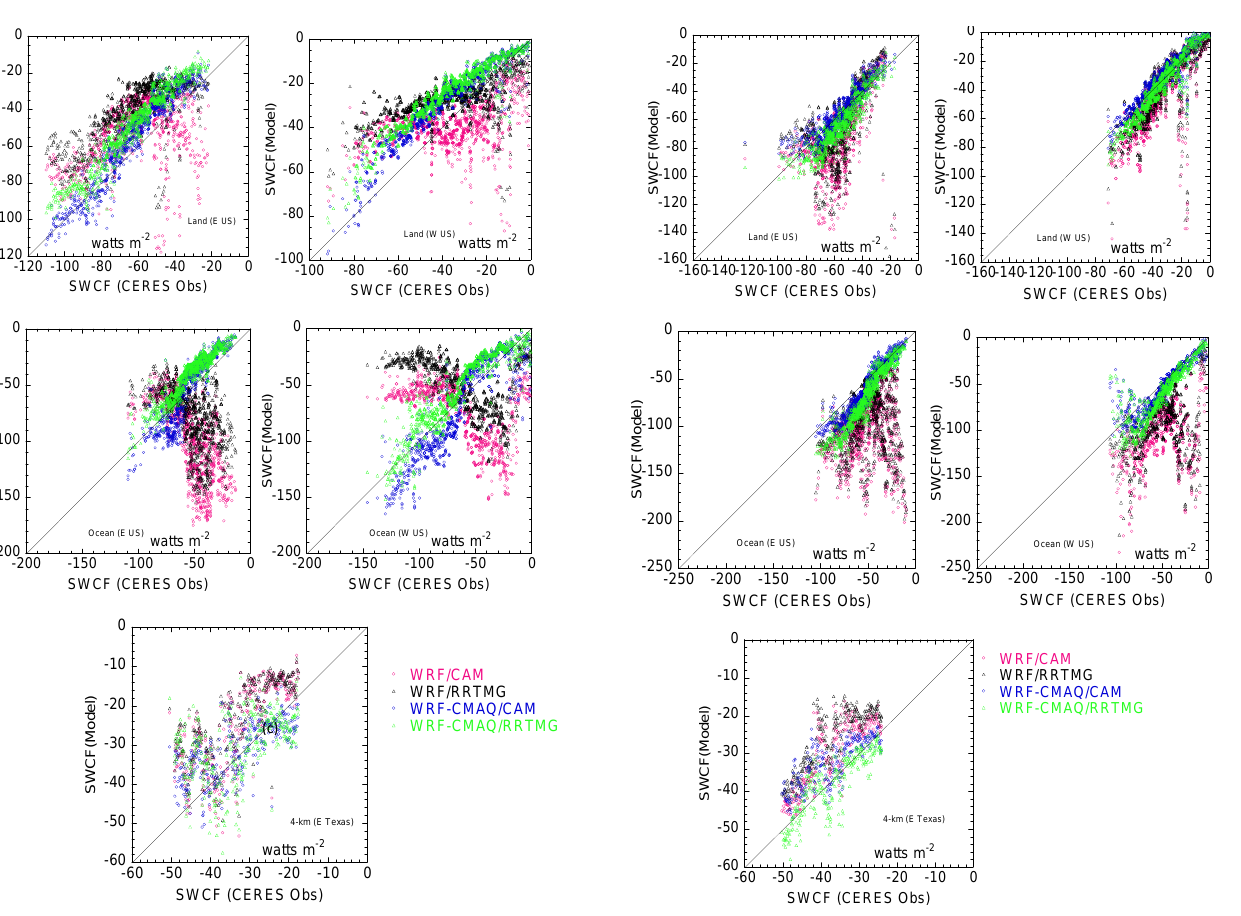
Figure 11. Scatter plots of modeled (WRF-CMAQ/CAM, WRF-CMAQ/RRTMG, WRF/CAM and WRF/RRTMG) and observed monthly mean SWCF over the land, and ocean of the eastern and western U.S for the 12-km resolution simulations (see Figure 9) and over the eastern Texas domain for the 4-km resolution simulations (see Figure 10) for August of 2006.